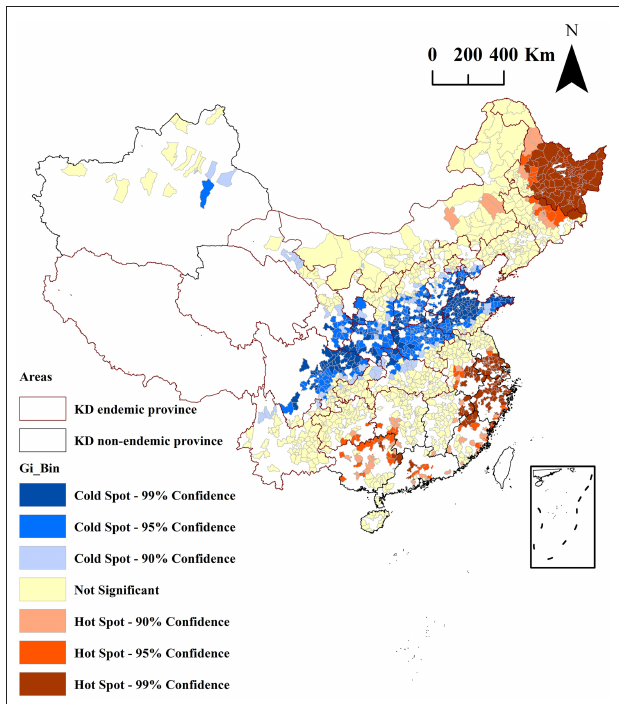
FIGURE 5 | Clusters identified by local Getis-Ord Gi* analysis for the mean serum SELENOP levels by county in China. Red borders in the spatial thematic map represent KD-endemic areas. Colors in the spatial thematic map represent hot spots and cold spots of spatial clustering with 90, 95, and 99%